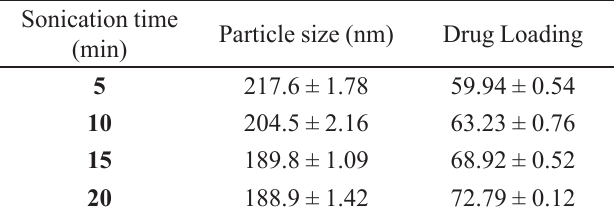
TABLE VI - Showing Optimization of Probe Sonication Sonication time